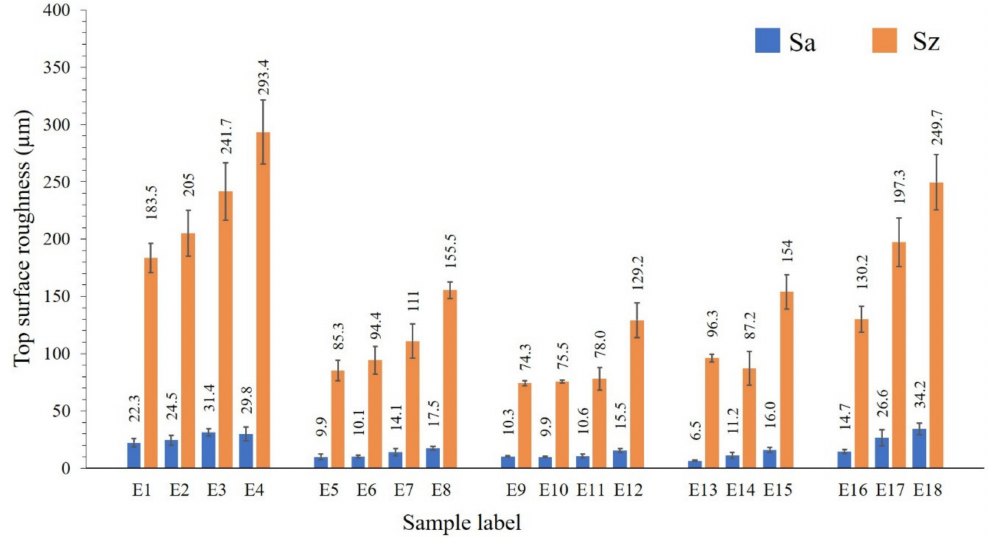
Figure 4. Top surface roughness results of samples